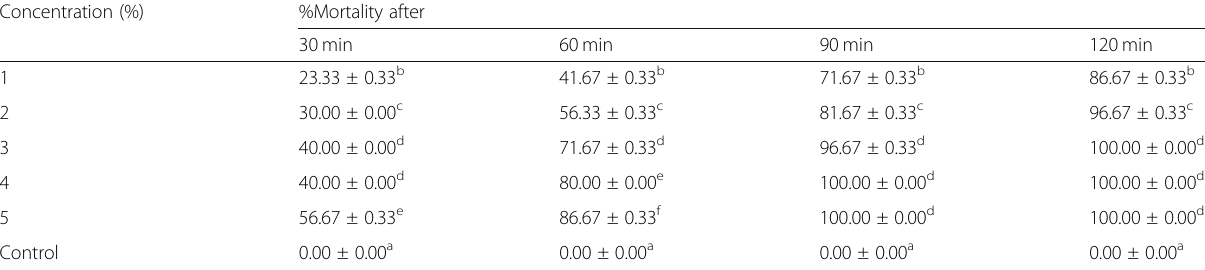
Table 3 Fumigant toxicity of synergistic application of P . alliacea root bark and leaf oil extract on the mortality of adult Culex